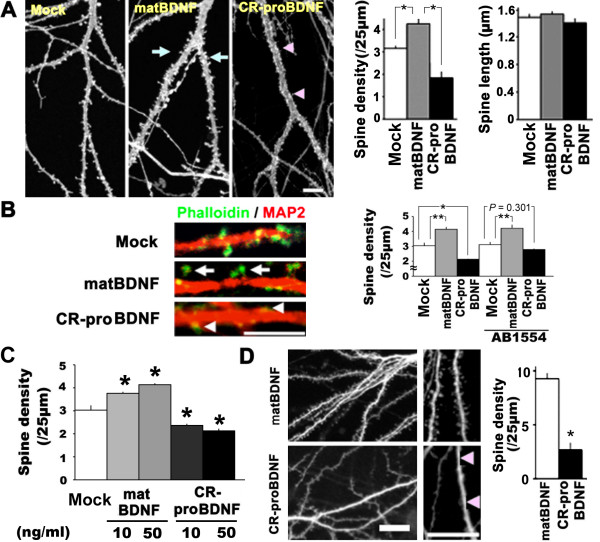
proBDNF reduces dendritic spine density in hippocampal neurons. Cultured neurons were maintained for 3–4 weeks and treated with the indicated reagents (50 ng/ml) for 2 (A, B, and D) or 3 days (C). In A and B, neurons were cultured in serum-containing medium. (A) CR-proBDNF reduced the density of DiI-labeled spines. Representative images of DiI-labeled neurons treated with the indicated reagents for 2 days (left). Summary of spine density (middle) and length (right). Data were collected from 52 (Mock), 59 (matBDNF), and 38 (CR-proBDNF) independent cells (non-parametric test, *P < 0.05, compared to Mock). Note that matBDNF increased spine density, while proBDNF reduced spine density (arrows and arrowheads). (B) proBDNF promoted the shrinkage of phalloidin-labeled spines and p75NTR was involved in the proBDNF action. Application of a functionally blocking antibody against p75NTR, AB1554 was performed and fixed neurons were stained with an anti-MAP2 antibody and FITC-labeled phalloidin. Representative images of the double-stained neurons (left) and a quantitative analysis of phalloidin-labeled spiny structures (right) are shown, n = 30–40 independent cells from three independent coverslips. t-test, *P < 0.05, **P < 0.01, compared to Mock (100% as control). (C) CR-proBDNF decreases spine density in low-density hippocampal neurons cultured in serum-free medium. The cultures were incubated with CR-proBDNF in serum-free medium for 2 days and double-stained with an anti-MAP2 antibody and FITC-labeled phalloidin. n = 24–32 cells from three independent coverslips. t-test, *P < 0.05, **P < 0.01, compared to Mock. (D) CR-proBDNF decreased spine density in hippocampal slices. Representative images of DiI-labeled neurons at low and high magnification are shown (left). A decrease in spine density was observed in CR-proBDNF-treated slices (arrow heads). Quantification of spine density (right). Data were collected from 7 (Mock) and 6 (CR-proBDNF) independent slices. Note that CR-proBDNF-treated slices showed a decrease in spine density when compared with matBDNF. t-test, *P < 0.05. Scale bar, 10 μm (A, B, and D).